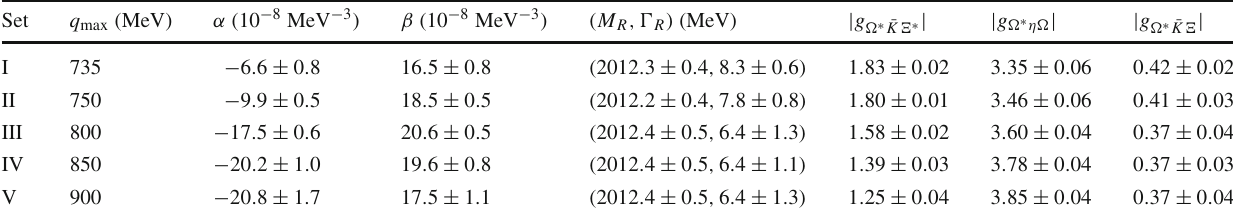
Table 2 Determined values of the unknown parameters in this work. We also give the pole positions ( M R ,(cid:6) R ) of the (cid:2)( 2012 ) and the couplings to different channel obtained with the central values of these fitted parameters Set